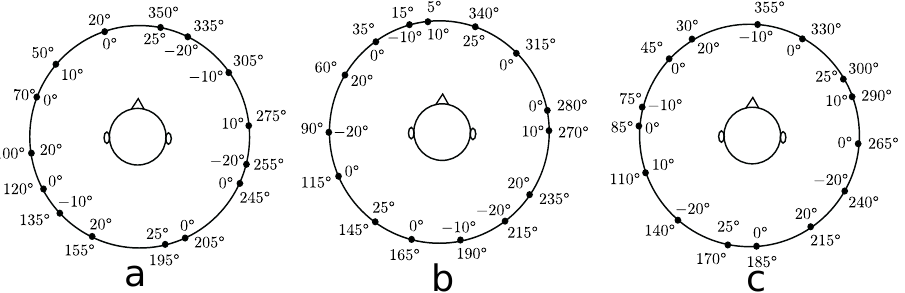
Figure 2. Target positions when localizing with ( a ) real sources in TestReal, ( b ) virtual sources in TestVR and ( c ) virtual sources in TestDyamic and TestStatic. Numbers outside and inside the circle indicate the azimuth angles and the levels of elevation of the target sources,